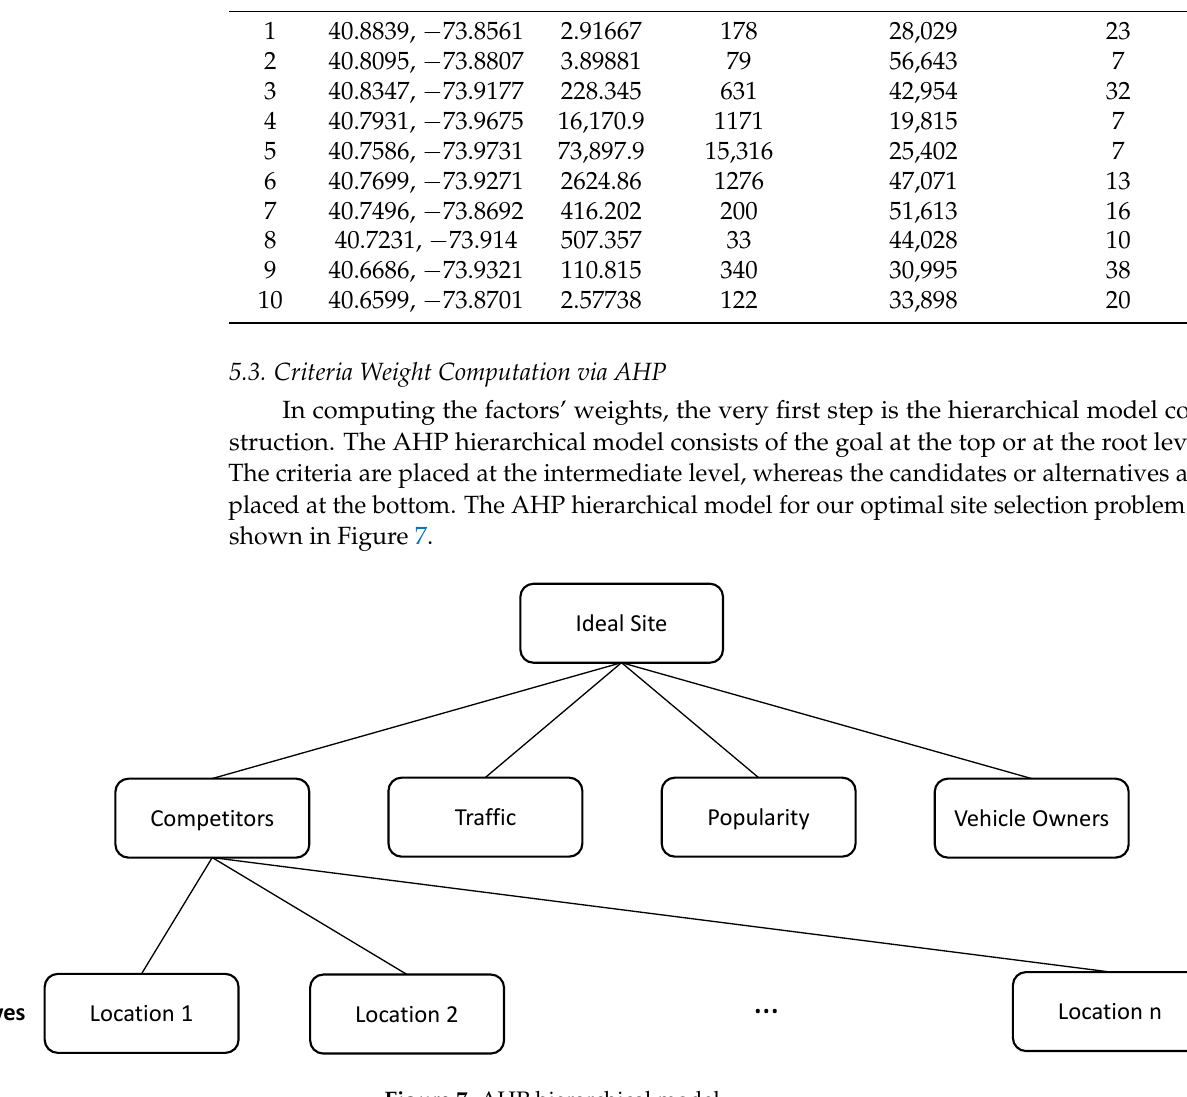
Figure 7. AHP hierarchical